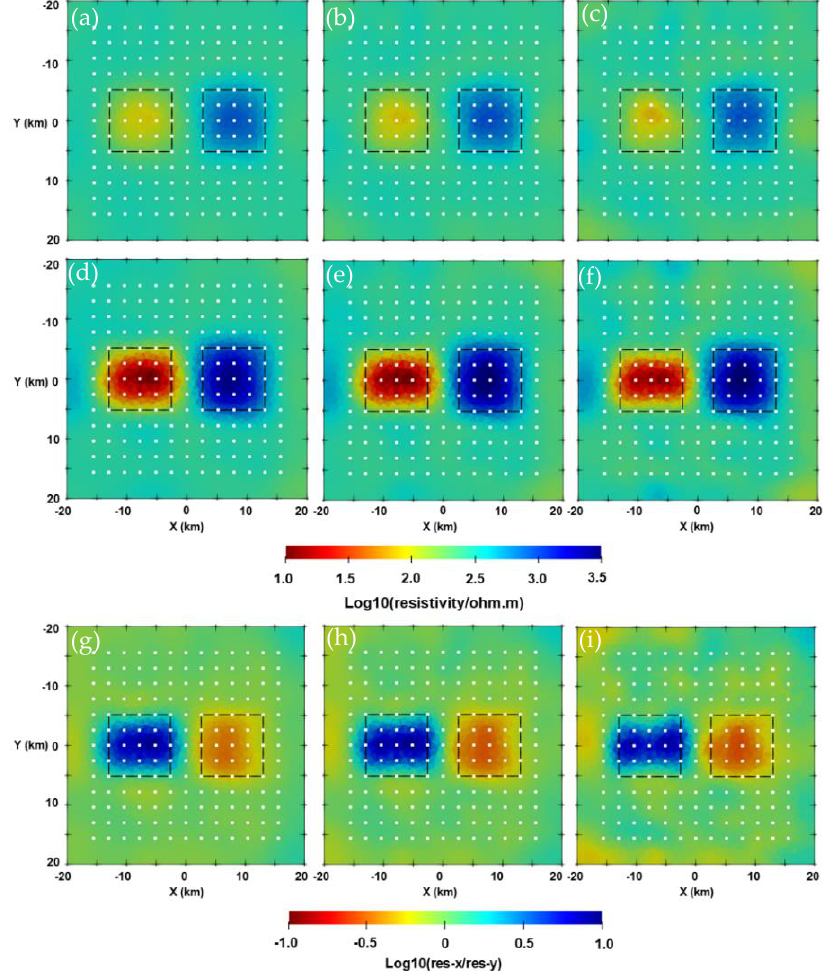
Figure A6. Anisotropic inversion results at z = 6 km for different c , and q i = 0.6. Panels ( a )–( c ) show the inverted resistivity in the principal X direction for c = 1,2,3. Panels ( d )–( f ) show the inverted resistivity in the principal Y direction for c = 1,2,3. Panels ( g )–( i ) show the inverted anisotropic coefficient for c =